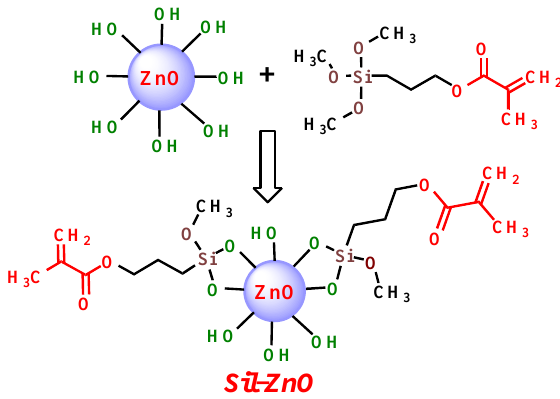
Figure 2. Schematic representation of the functionalization of ZnO nanoparticles.